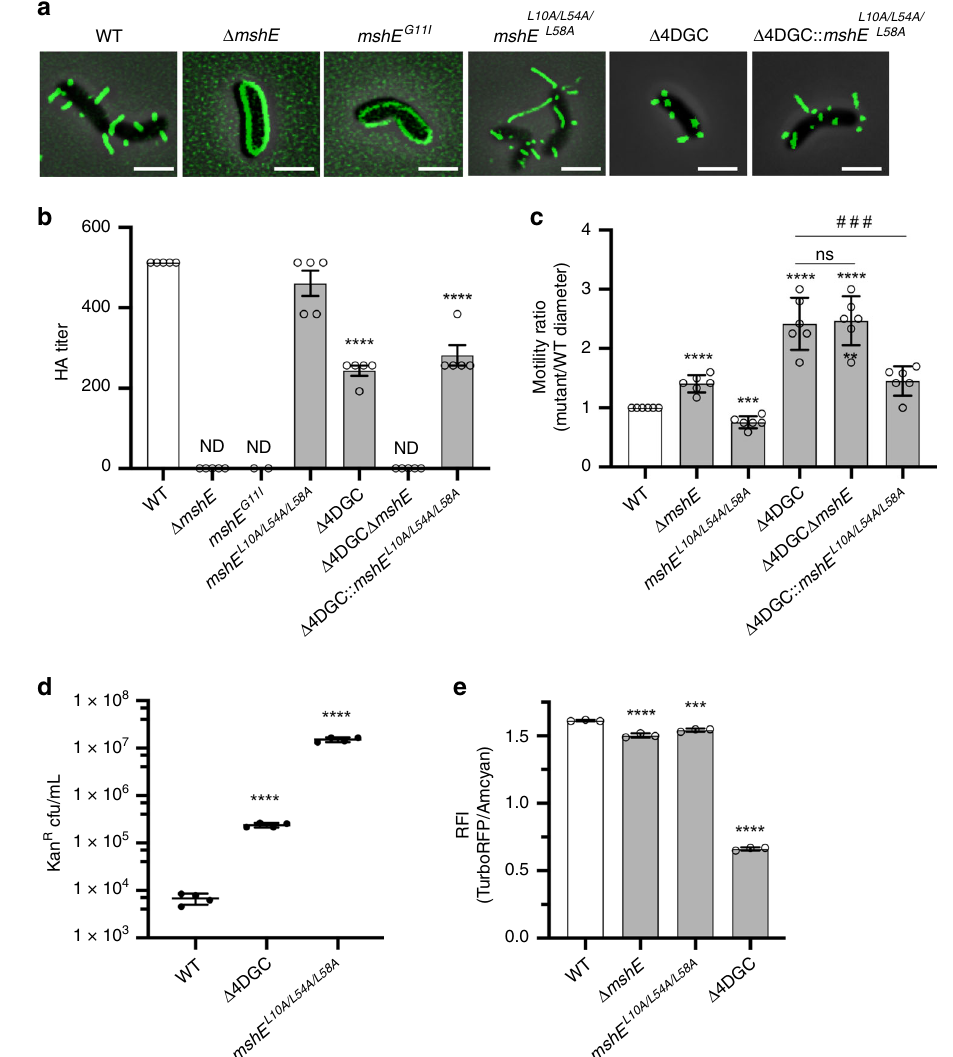
Fig. 4 Enhanced retraction under low c-di-GMP conditions results from altered MshE activation or functional state. a Representative overlay images of fi ltered- fl uorescence and phase-contrast channels of mshA T70C strains within surface-associated cells stained with AlexaFluor 488 C 5 maleimide dye. Images representative of 3 independent analyses. Scale bars = 2 μ m. b Analysis of surface MSHA production via hemagglutination (HA) assay. The reciprocal of the lowest fold dilution at which equivalent cell levels were able to agglutinate sheep erythrocytes (HA Titer) is plotted as the mean with error bars representing the SEM. For each strain n = 5 biological replicates ( mshE G11I n = 2), with two technical replicates performed for each biological replicate. WT and Δ 4DGC values are the same as shown in Fig. 3e. ND no observable hemagglutination at the highest cell concentration. Statistical analysis: each mutant HA titer was compared to WT via unpaired two-tailed Student ’ s t -Test, **** p ≤ 0.0001. Source data provided as a Source Data fi le. c Flagellar motility in soft agar. Data presented as the ratio of mutant motility to WT motility. Graphs depict data as the mean, with error bars representing the standard deviation. n = 6 biological replicates per strain. Statistical analysis: unpaired two-tailed Student ’ s t -Test, each strain compared to WT **** p ≤ 0.0001, *** p = 0.0001, ** p = 0.0012; ### Δ 4DGC vs Δ 4DGC:: mshE L10A/L54A/L58A p = 0.0009, Δ 4DGC Δ mshE vs Δ 4DGC:: mshE L10A/L54A/L58A p = 0.0004. d VGJ Φ phage transduction levels. All in mshA T70C strain. Individual data points of kanamycin-resistant CFU/mL plotted with line at the mean and error bars representing the standard deviation. Biological replicates: n = 3 per strain. Statistical analysis: unpaired two-tailed Student ’ s t -Test, **** p ≤ 0.0001. e Planktonic exponential phase c-di-GMP levels determined with the Bc3-5 biosensor. Data presented as mean with standard deviation, n = 3 biological replicates per strain. Statistical analysis, One-way ANOVA compared to WT with Dunnett correction for multiple comparisons, *** p = 0.0002, **** p ≤ 0.0001. Source data provided as a Source Data fi